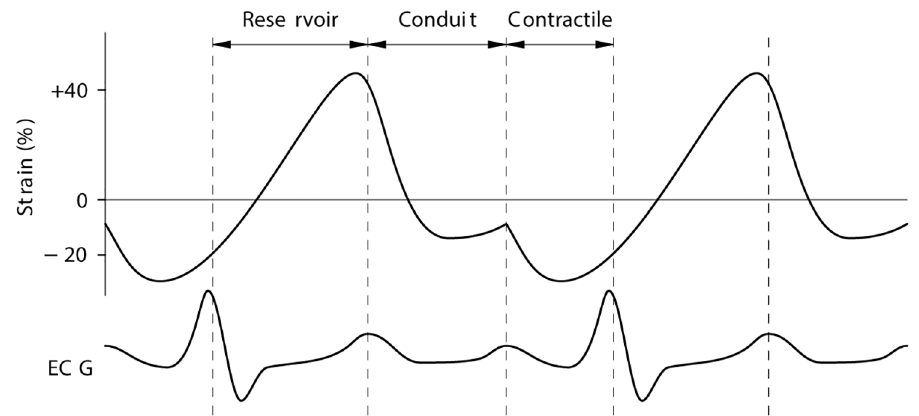
Fig 2. Triphasic atrial longitudinal strain dynamics during the cardiac cycle. ECG,